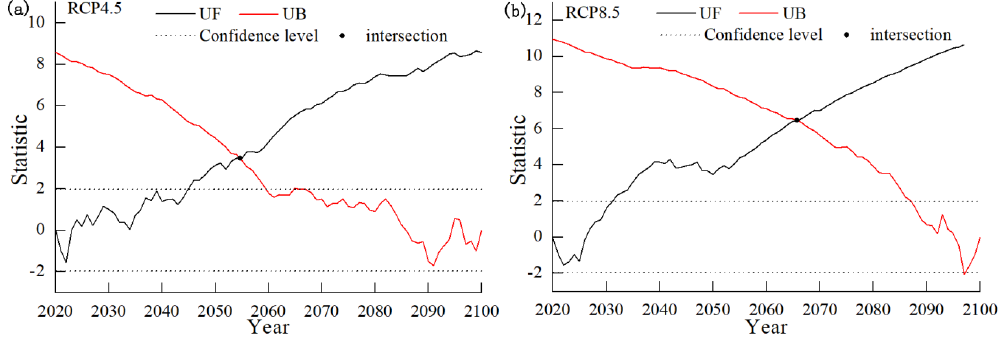
Figure 4. Mann–Kendall test of annual mean temperature in the Lancang–Mekong sub-region under the RCP4.5 ( a ) and the RCP8.5 ( b ).